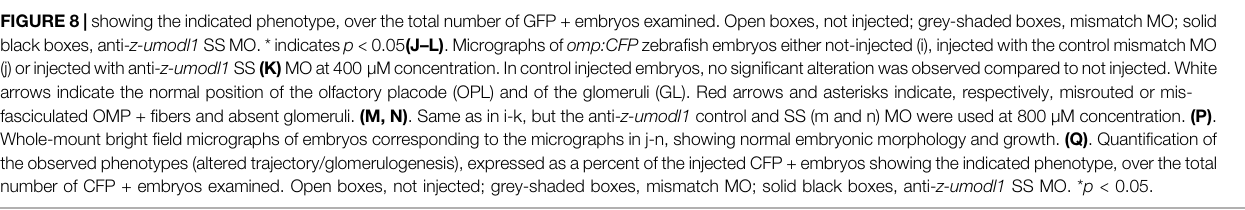
FIGURE 8 | showing the indicated phenotype, over the total number of GFP + embryos examined. Open boxes, not injected; grey-shaded boxes, mismatch MO; solid black boxes, anti- z-umodl1 SSMO. * indicates p < 0.05 (J – L) . Micrographs of omp:CFP zebra fi sh embryos eithernot-injected (i), injected withthe control mismatch MO (j)orinjectedwithanti- z-umodl1 SS (K) MOat400 μ Mconcentration.Incontrolinjectedembryos,nosigni fi cantalterationwasobservedcomparedtonotinjected.White arrows indicate the normal position of the olfactory placode (OPL) and of the glomeruli (GL). Red arrows and asterisks indicate, respectively, misrouted or mis- fasciculated OMP + fi bers and absent glomeruli. (M, N) . Same as in i-k, but the anti- z-umodl1 control and SS (m and n) MO were used at 800 μ M concentration. (P) . Whole-mount bright fi eld micrographs of embryos corresponding to the micrographs in j-n, showing normal embryonic morphology and growth. (Q) . Quanti fi cation of the observed phenotypes (altered trajectory/glomerulogenesis), expressed as a percent of the injected CFP + embryos showing the indicated phenotype, over the total number of CFP + embryos examined. Open boxes, not injected; grey-shaded boxes, mismatch MO; solid black boxes, anti- z-umodl1 SS MO. * p <